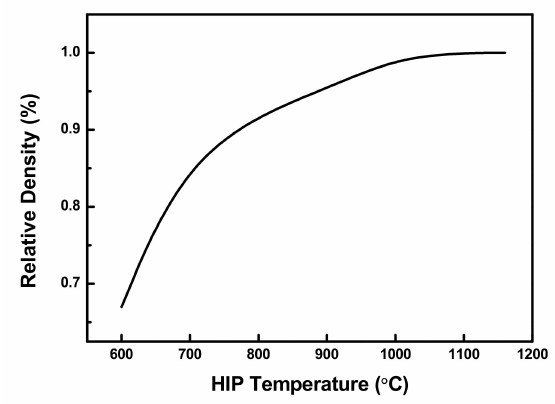
Figure 8. Relative density curve with HIP sintering